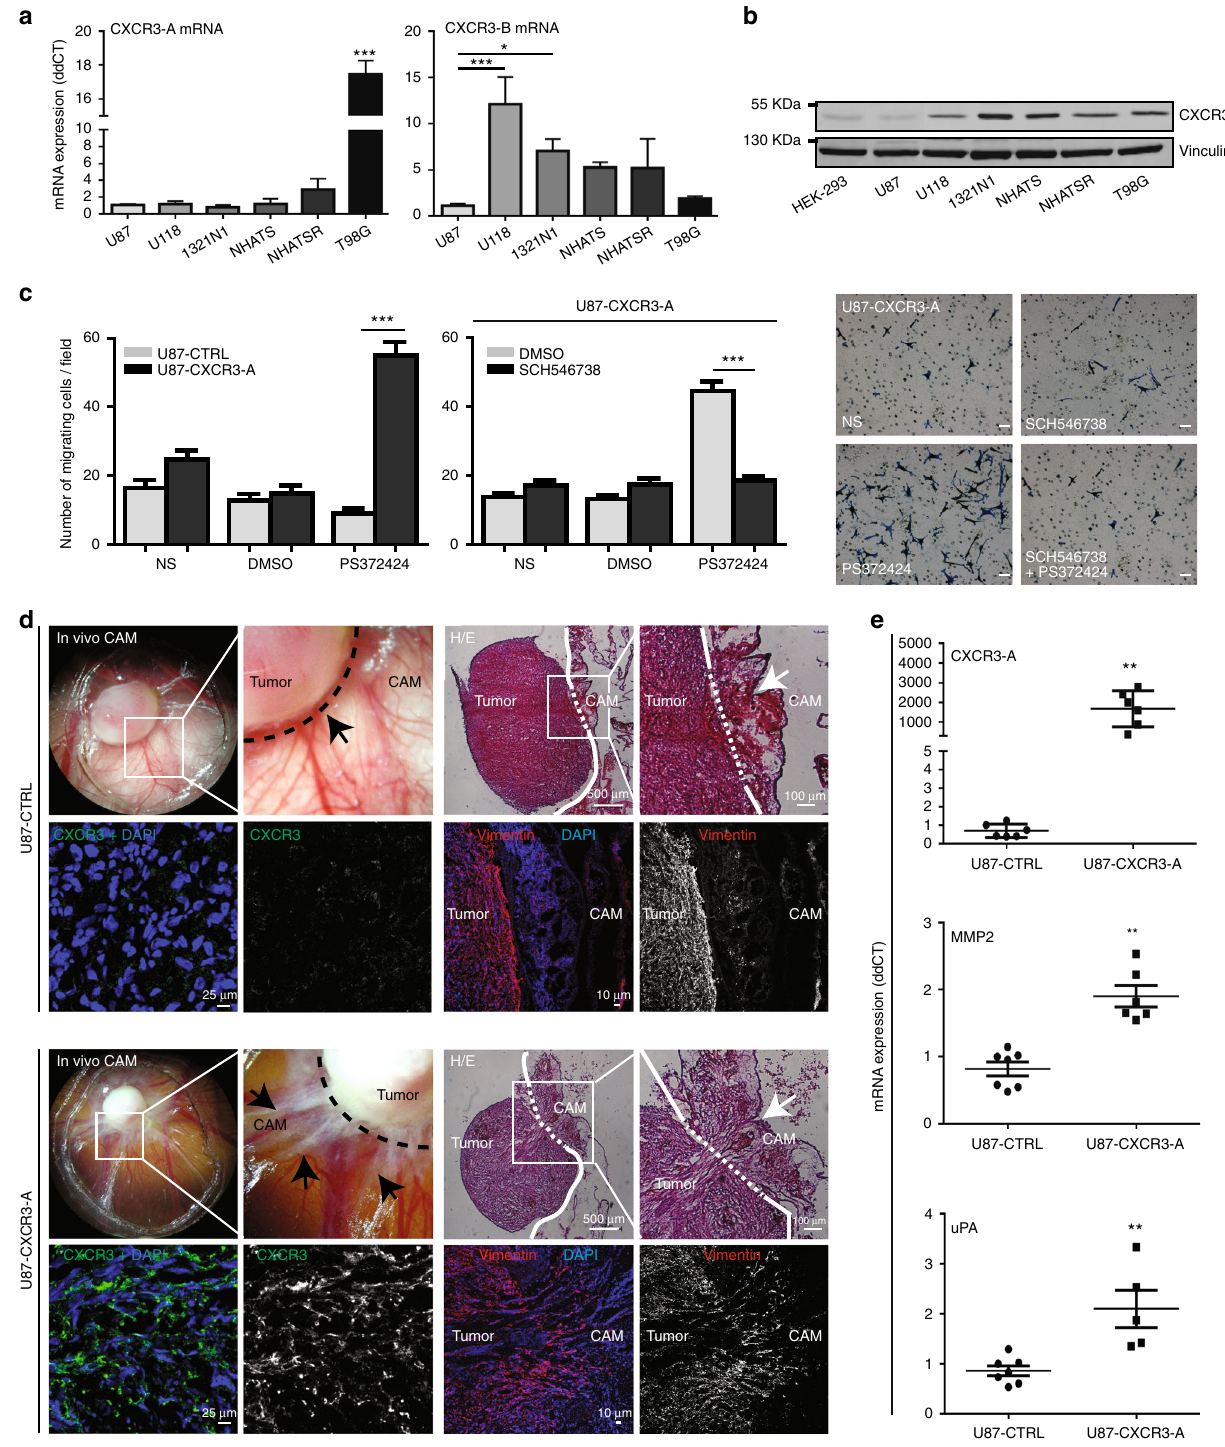
Fig. 1 Expression and functional role of CXCR3-A in glioma. a Relative CXCR3 isoform mRNA expression in low (1321N1, NHATS, and NHATSR) and high- grade (U87, U118, and T98G) glioma. Values normalized to those obtained for U87 cell line. b CXCR3 protein expression in HEK-293 and glioma cell lines. Vinculin was used as a loading control. c Migration assays using CXCR3 agonist PS372424 (100 ng/ml) were performed in U87-CTRL and U87-CXCR3-A cells. U87-CXCR3-A cells were pretreated or not with CXCR3 antagonist SCH546738. NS non-stimulated condition, DMSO negative control. d CAM assays were performed using U87-CTRL ( n = 21 eggs) or U87-CXCR3-A cells ( n = 23 eggs). Seven days after implantation, images of CAM tumors with CXCR3 immunostaining and HE staining with corresponding vimentin immunostaining were performed in U87-CTRL and U87-CXCR3-A. e Relative CXCR3-A, MMP-2, or uPA mRNA expression in U87-CTRL and U87-CXCR3-A tumors ( n = 7 eggs for each condition). All the results from three independent experiments were combined to calculate mean and SEM, and values were normalized to those obtained for the control cells. *** P < 0.001, ** P < 0.01, * P < 0.05. Multiple comparisons were performed with one-way analysis of variance, followed by Bonferroni post hoc tests. Statistical comparison between two groups was performed using the Mann – Whitney U